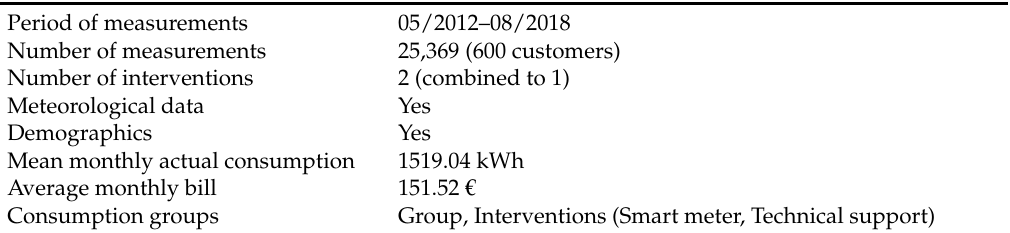
Table 8. Highlights of EBO’s